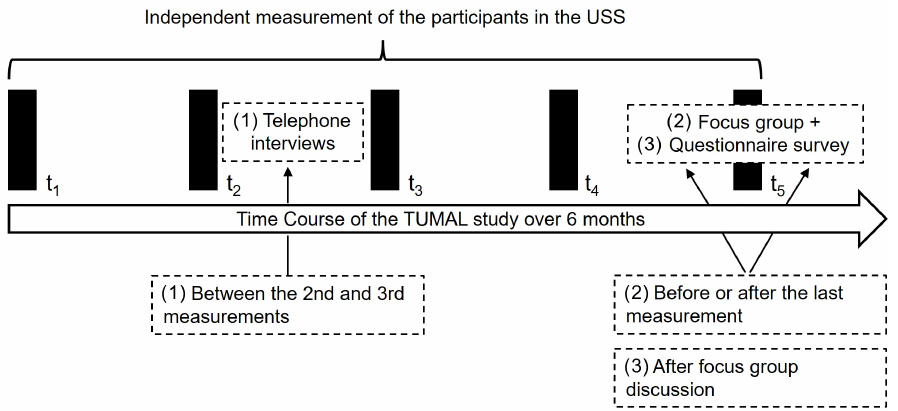
Figure 8. The protocol of the TUMAL